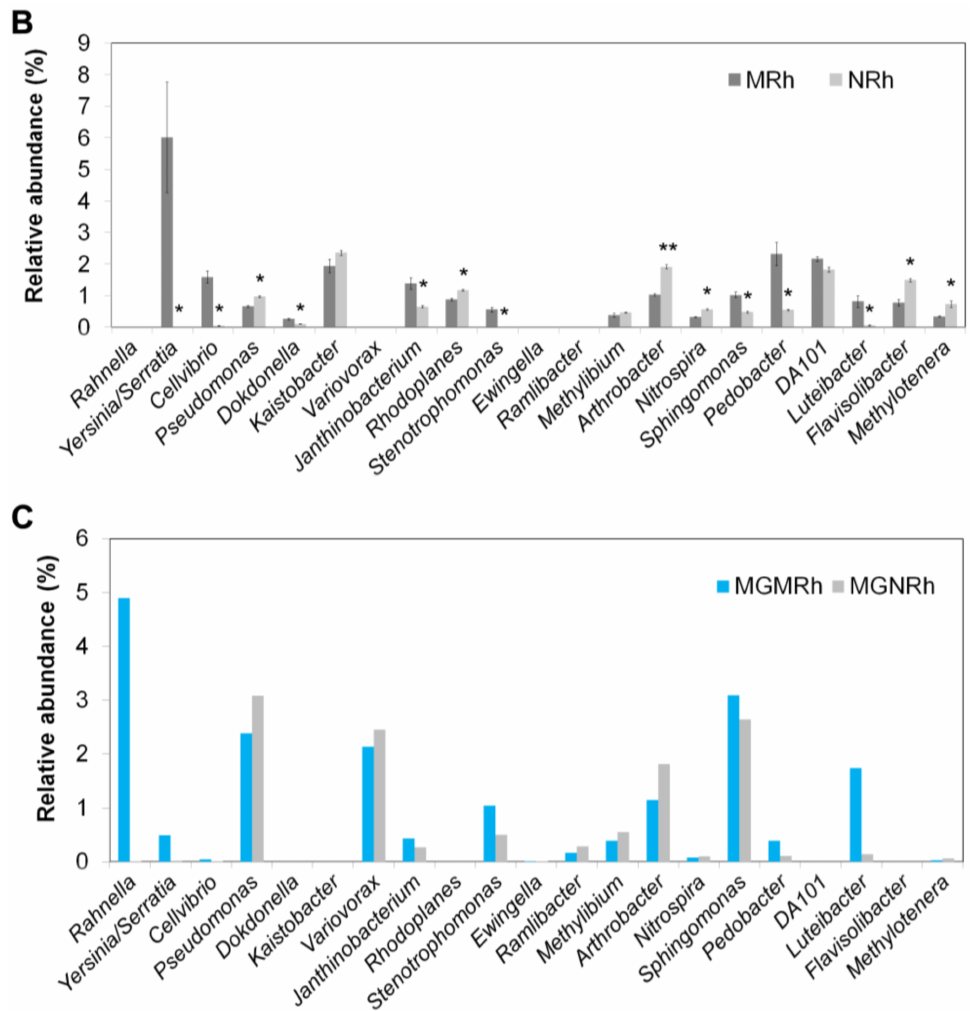
Figure 3. Comparison of the relative abundances of top 10 dominant genera in the rhizospheric soil between N698 and MD12. ( A ) Results revealed by 16S rDNA V5–V7 hypervariable region amplicon deep sequencing. ( B ) Results revealed by 16S rDNA V4 hypervariable region amplicon deep sequencing. ( C ) Results revealed by shotgun metagenomic approaches (analyzed by One Codex). Error bars indicate standard errors; * p < 0.05; ** p < 0.01. MRh1–3 and NRh1–3 represent three biological rhizospheric soil replicates of MD12 (MRh) and those of N698 (NRh), respectively. MGMRh and MGNRh represent pooled rhizospheric DNA sample of MRh and NRh for shotgun metagenome sequencing,